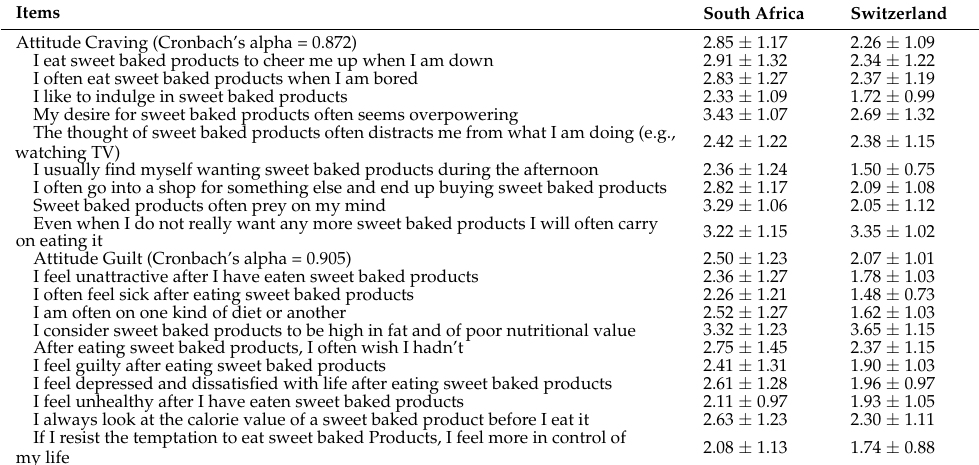
Table 4. Mean and standard deviation (m ± sd) values of the sensory properties of biscuits. Items South Africa Switzerland Sensory taste properties (Cronbach’s alpha = 0.707) 2.69 ± 1.07 2.46 ± 0.87 Chocolate 3.80 ± 1.06 Vanilla Buttery Sweet Caramel Nutty 1.58 ± 1.07